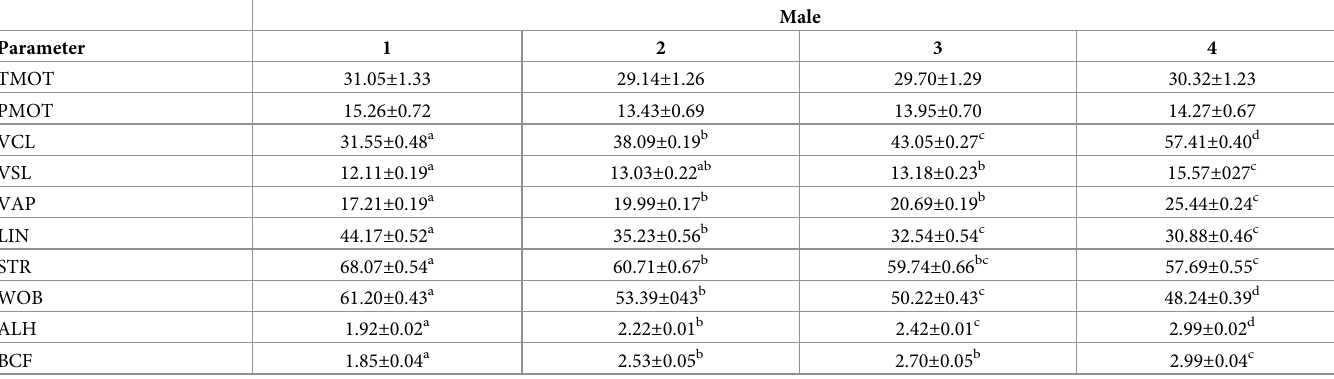
Table 3. Motility and sperm kinematic variables (mean ± SEM) in American crocodiles ( Crocodylus acutus ) (two ejaculates/male).